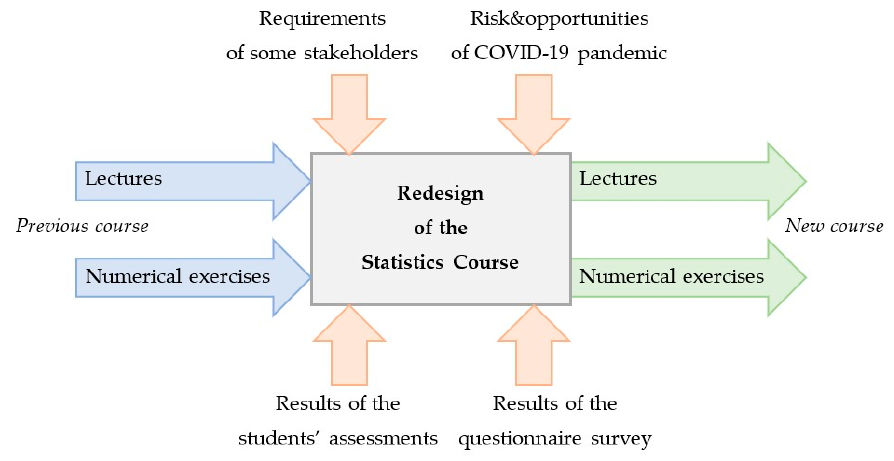
Figure 1. The redesign of the Statistics course; this includes the key resources.